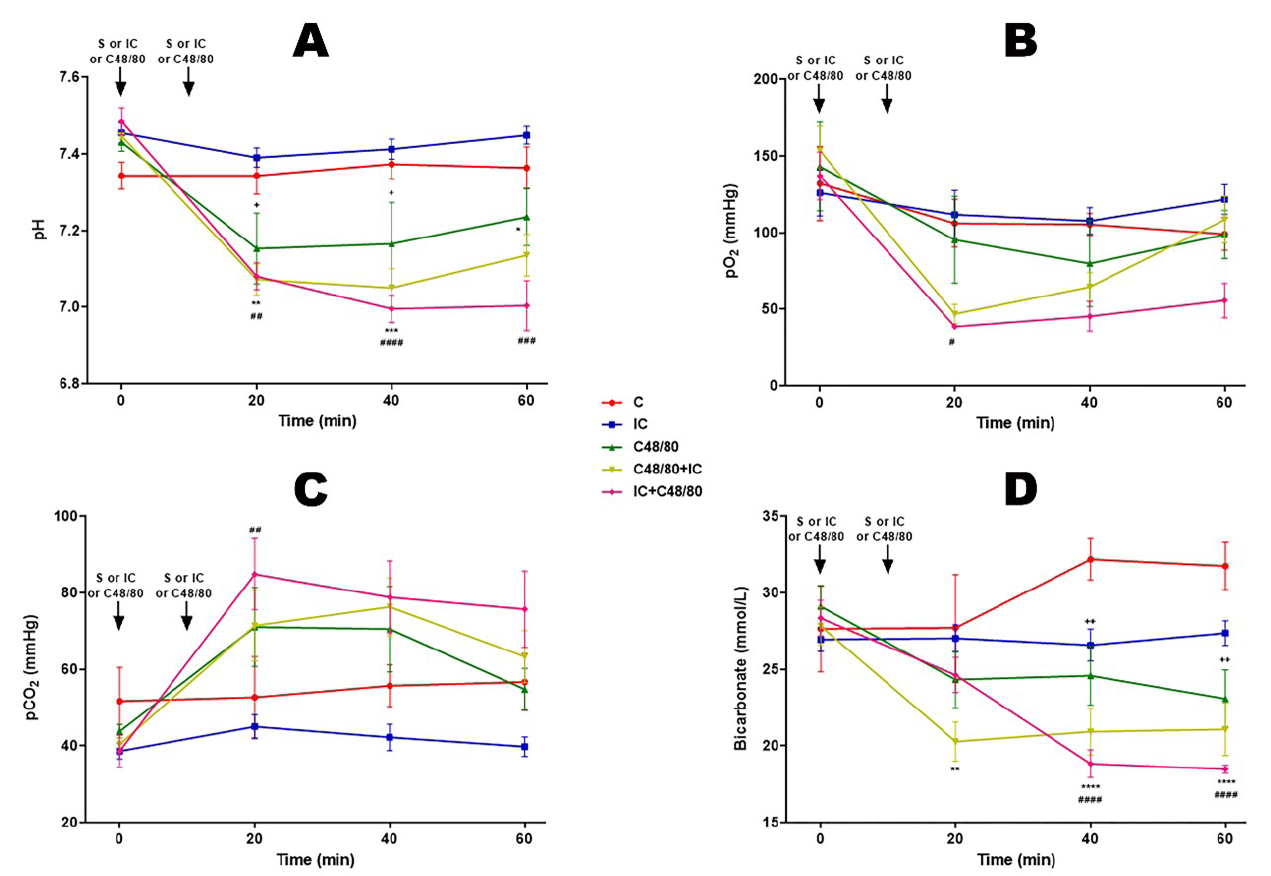
Fig. 4 - Acid-base data. Effect of anaphylactic shock caused by compound 48/80 (C48/80) and treated with indigo carmine (IC) in pigs. A) pH;